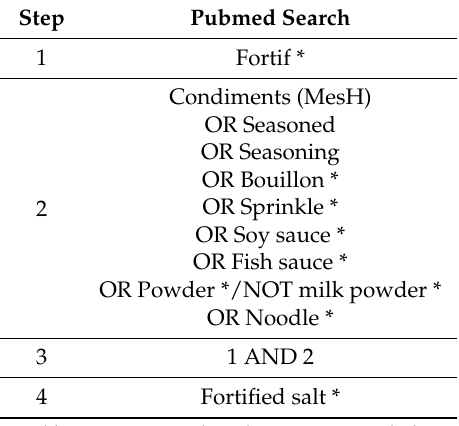
Table 1. Pubmed electronic search strategy. Identified records result from steps 3 and 4.